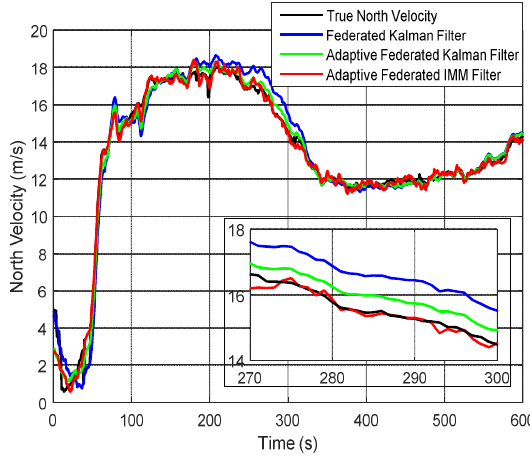
Sensors 2020 , 20 , x FOR PEER REVIEW Figure 15. The estimation curves of north velocity. Figure 15. The estimation curves of north velocity.